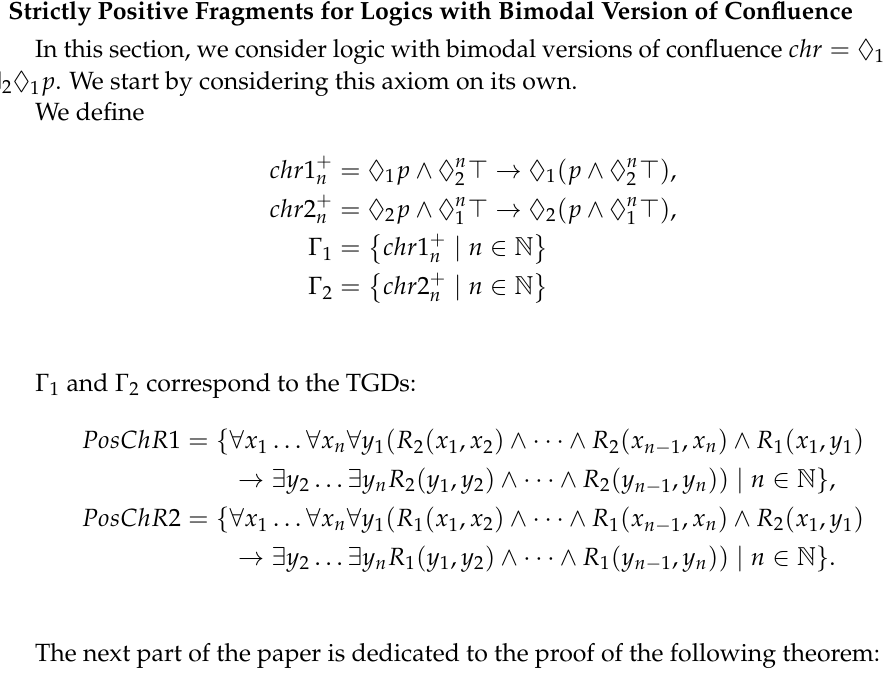
) , root | = ♦ ♦ 3 (cid:62) , ChRos 1 p ∧ 2 is n